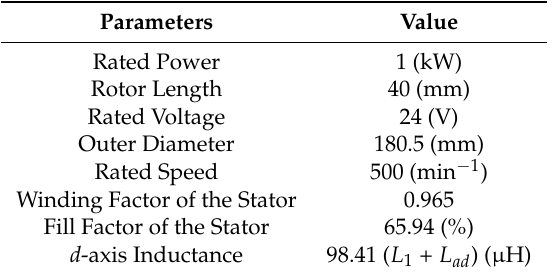
Figure A2. Proposed field weakening algorithm. Table A1. Specifications and parameters of the manufactured BLDC motor.